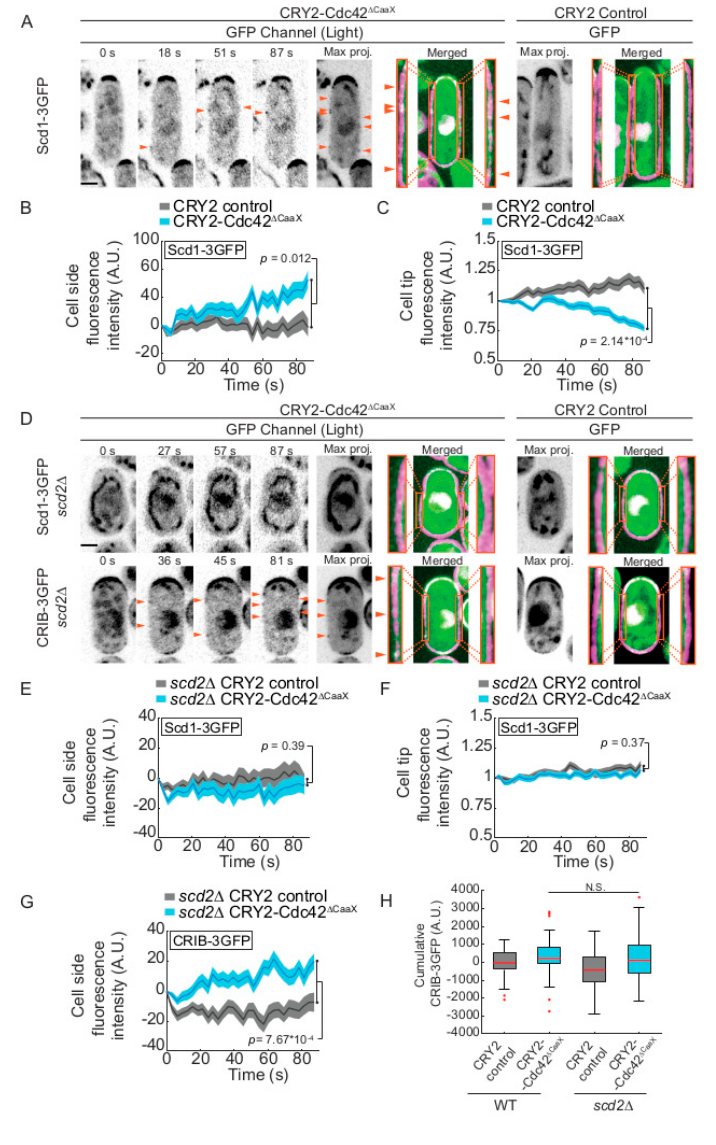
Figure 3. CRY2-Cdc42 ∆ CaaX recruits the GEF Scd1 dependent on the sca ff old Scd2. ( A ) Localization of Scd1-3GFP in CRY2-Cdc42 ∆ CaaX -expressing cells (B / W inverted images and green channel in merge). The GFP max projection (“max proj.”) images show GFP maximum-intensity projections of 30 time points over 87 s. Merged images are composites of GFP and RFP max projections (t0 omitted from the RFP projection). Magnification of the lateral cortex is shown in the orange insets. Arrowheads point to lateral Scd1-3GFP signal. ( B , C ) Quantification of Scd1-3GFP signal intensity at cell sides ( B ) and cell poles ( C ). n > 71 cells. Exact numbers are listed in the methods. ( D ) Localization of Scd1-3GFP and CRIB-3GFP in CRY2-Cdc42 ∆ CaaX -expressing scd2 ∆ cells. Layout as in panel A. ( E , F ) Quantification of Scd1-3GFP at cell sides ( E ) and cell poles ( F ) of scd2 ∆ mutant. n > 74 cells. Exact numbers are listed in the methods. ( G ) Quantification of CRIB-3GFP at cell sides of scd2 ∆ mutants. n > 84 cells. Exact numbers are listed in the methods. ( H ) Comparison of cumulative CRIB-3GFP intensities in WT and scd2 ∆ CRY2 and CRY2-Cdc42 ∆ CaaX cells; in scd2 + p control vs. CRY2-Cdc42 = 0.019 (data from Figure 1E); in scd2 ∆ p control vs. CRY2-Cdc42 = 7.67 × 10 − 4 (data from panel 3G); p CRY2-Cdc42 in WT vs. scd2 ∆ = 0.4. In all graphs, thick line = average; shaded area = standard error of the mean (SEM); WT, wild type; A.U., arbitrary units. Bars = 2 µ m. Associated trace analysis is shown in Figure S6. Autofluorescent organelles appear as linear and circular structures in some of the GFP channel